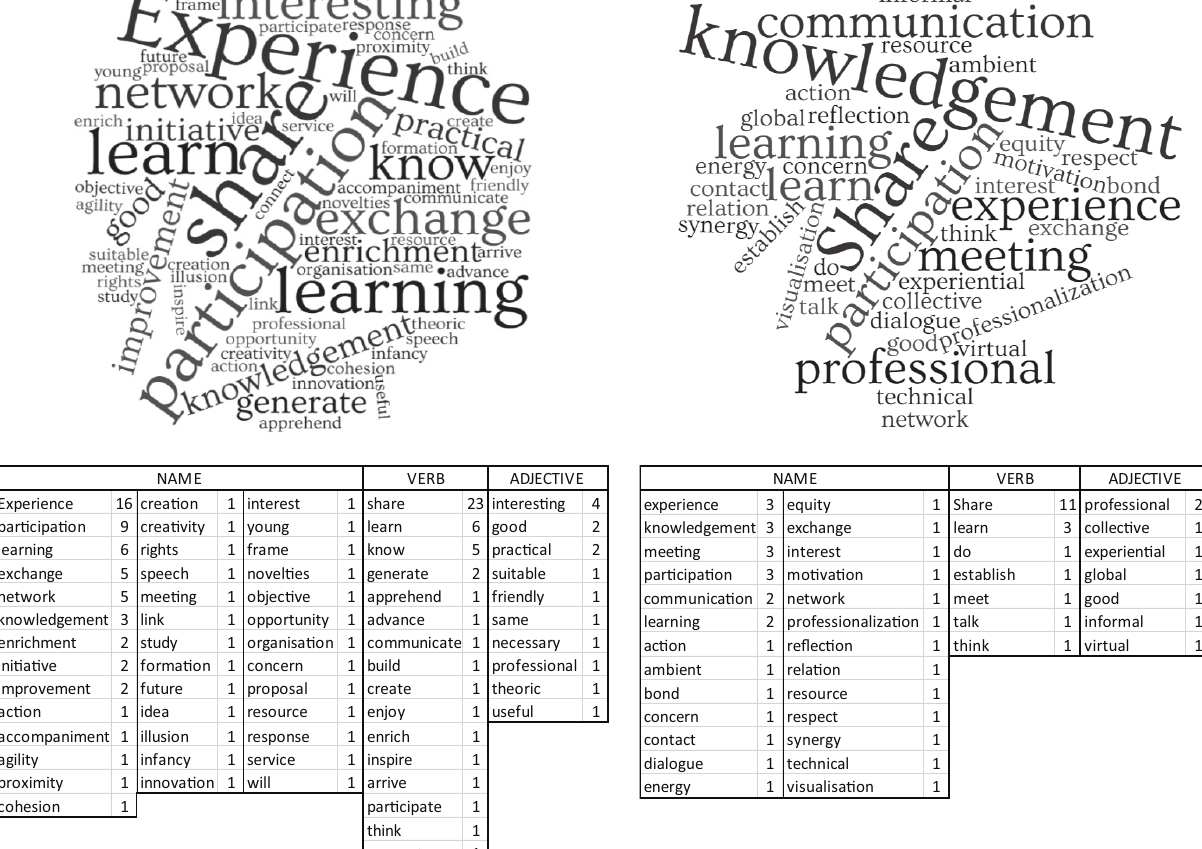
Figure 2. Word clouds and frequency tables according to the answer to the question: “When I think of the coffee space, the three words that come to mind